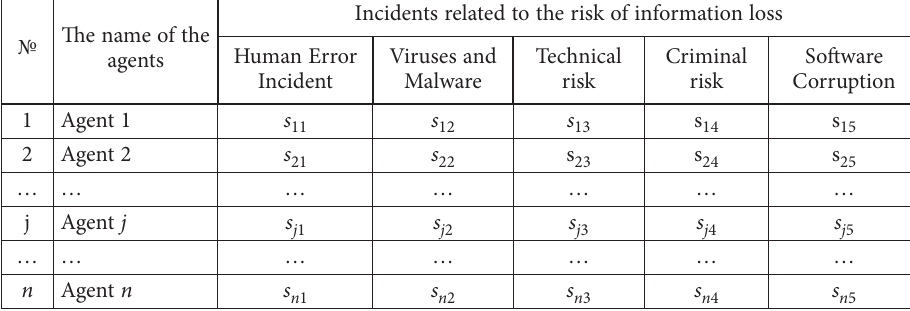
Table 2. Amounts of losses related to the cases in the business of the company (source: compiled by author) The name of the №